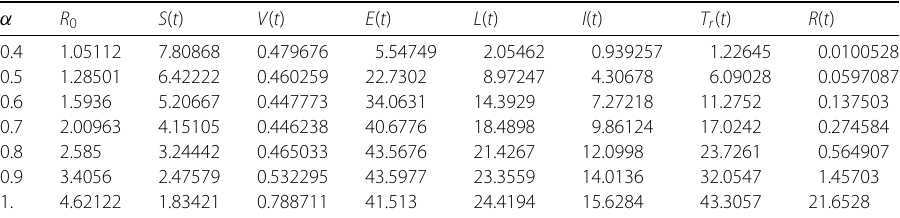
Table 4 Basic reproduction number R 0 and endemic equilibrium point (cid:13) 2 for set 2 and τ = 0.035 at different values of α